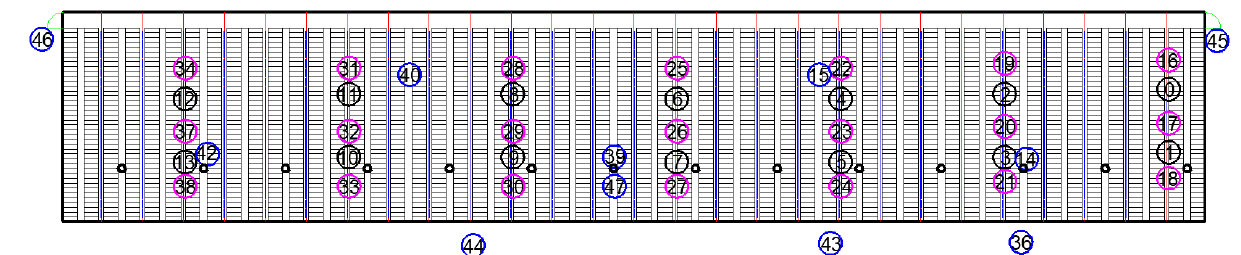
Figure 2. Schematic diagram of sensor layout in the pregnant sow piggery. Note: Height of nodes No. 0–13 in the figure is 150 cm; height of nodes No. 16–34, 37, and 38 is 60 cm; height of nodes No. 14, 15, 39, 40, 42, and 47 is 150 cm; height of nodes No. 43 and 44 behind the wet curtain is 100 cm; height of nodes No. 44 and 45 outdoors is 100 cm.